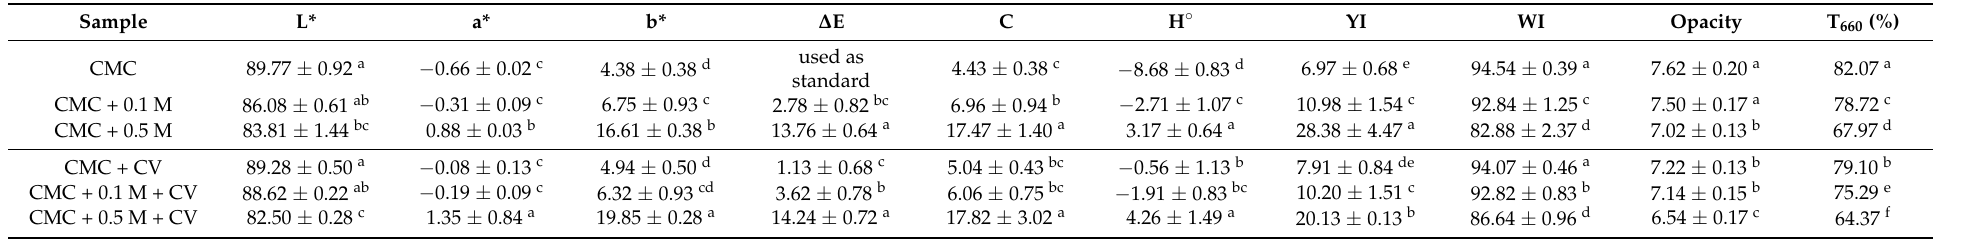
Table 3. Colour, total colour difference ( ∆ E), chroma (C), hue angle (H ◦ ), yellowness index (YI), whiteness index (WI), opacity, and transmittance at 660 nm of CMC-based films.